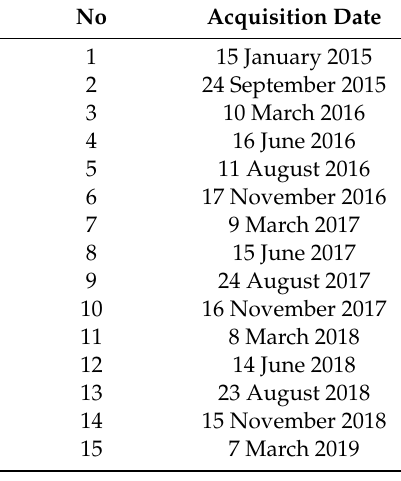
Table 2. List of used PALSAR ‐ 2 data (path number: 18).